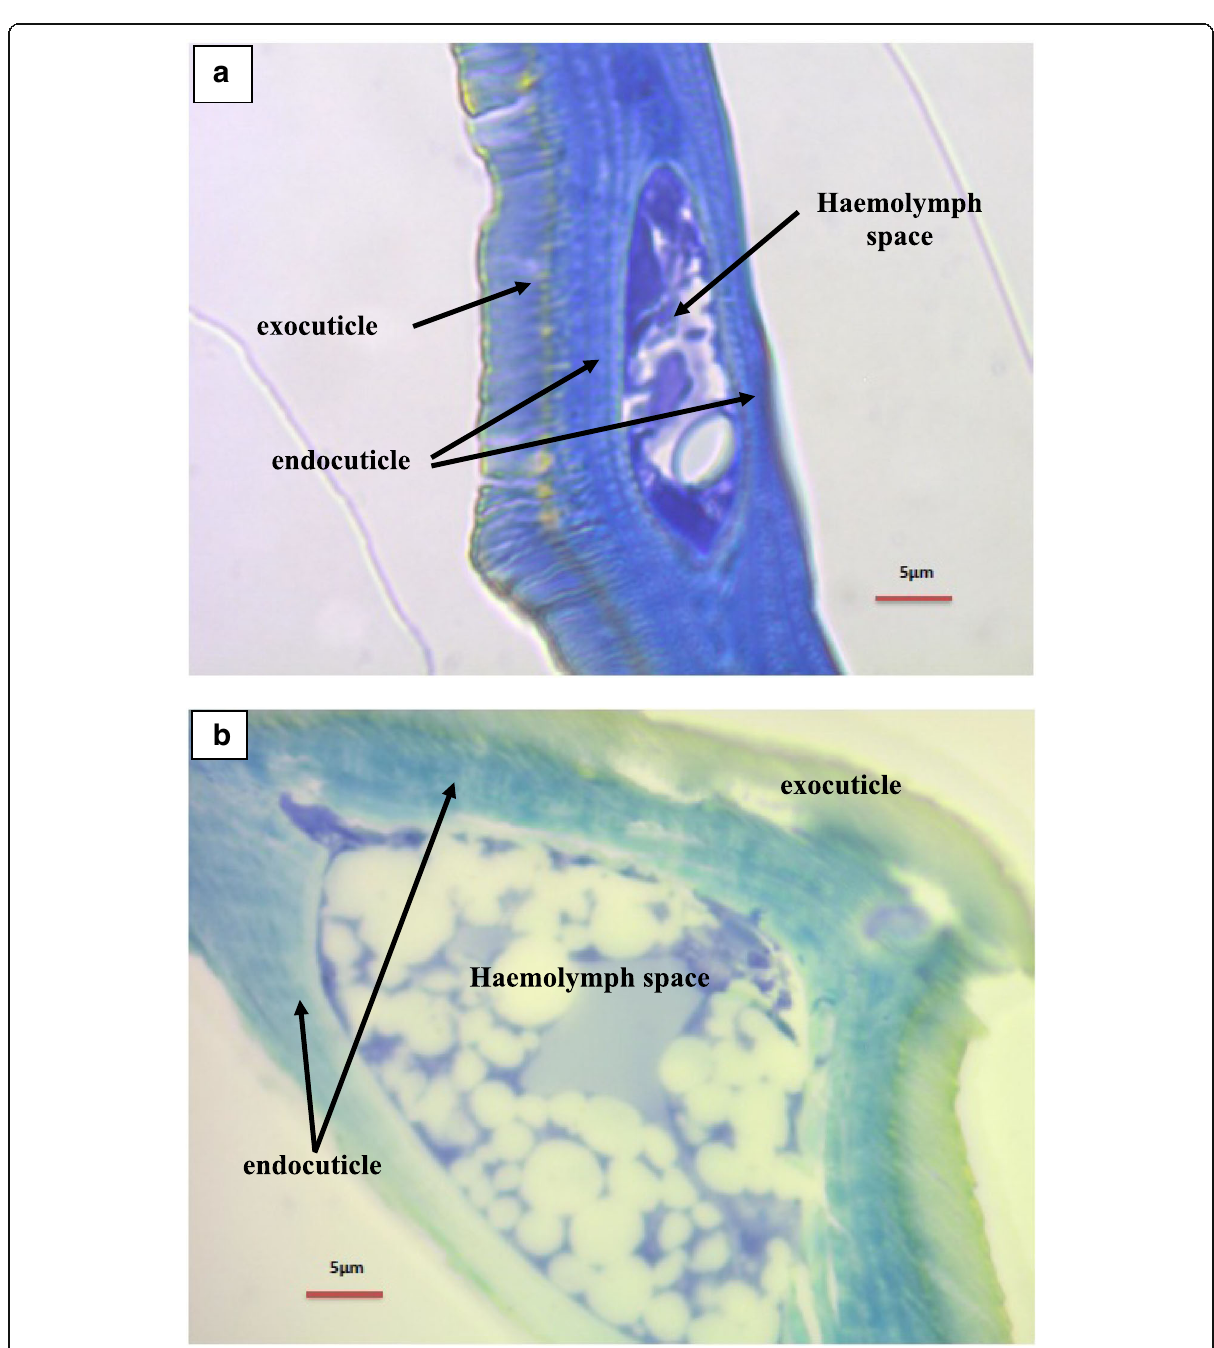
Fig. 7 Semi cross section of forewing of Tribolium sp. ( a ) Tribolium confusum ( b ) Tribolium castanaeum , showing thickness of exocuticle, endocuticle & the height of the haemolymph